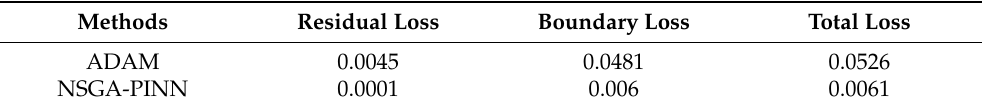
Figure 10. Burgers equation with data noise: the left column shows the residual loss. The right column shows the boundary loss. Table 4. Burgers equation: Comparison of the loss value from NN trained by ADAM method and NSGA-PINN method for Burgers equation with noisy